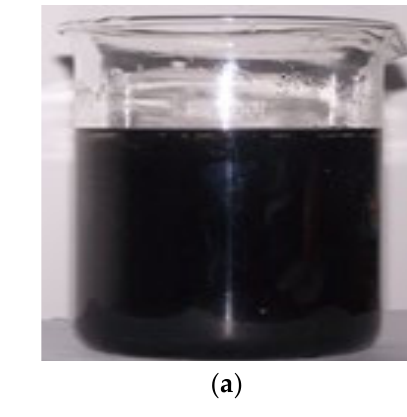
Figure 7. The state of the particles in the polymer solution. ( a ) Suspended state of particles in solution, ( b ) Settling state of particles in solution.